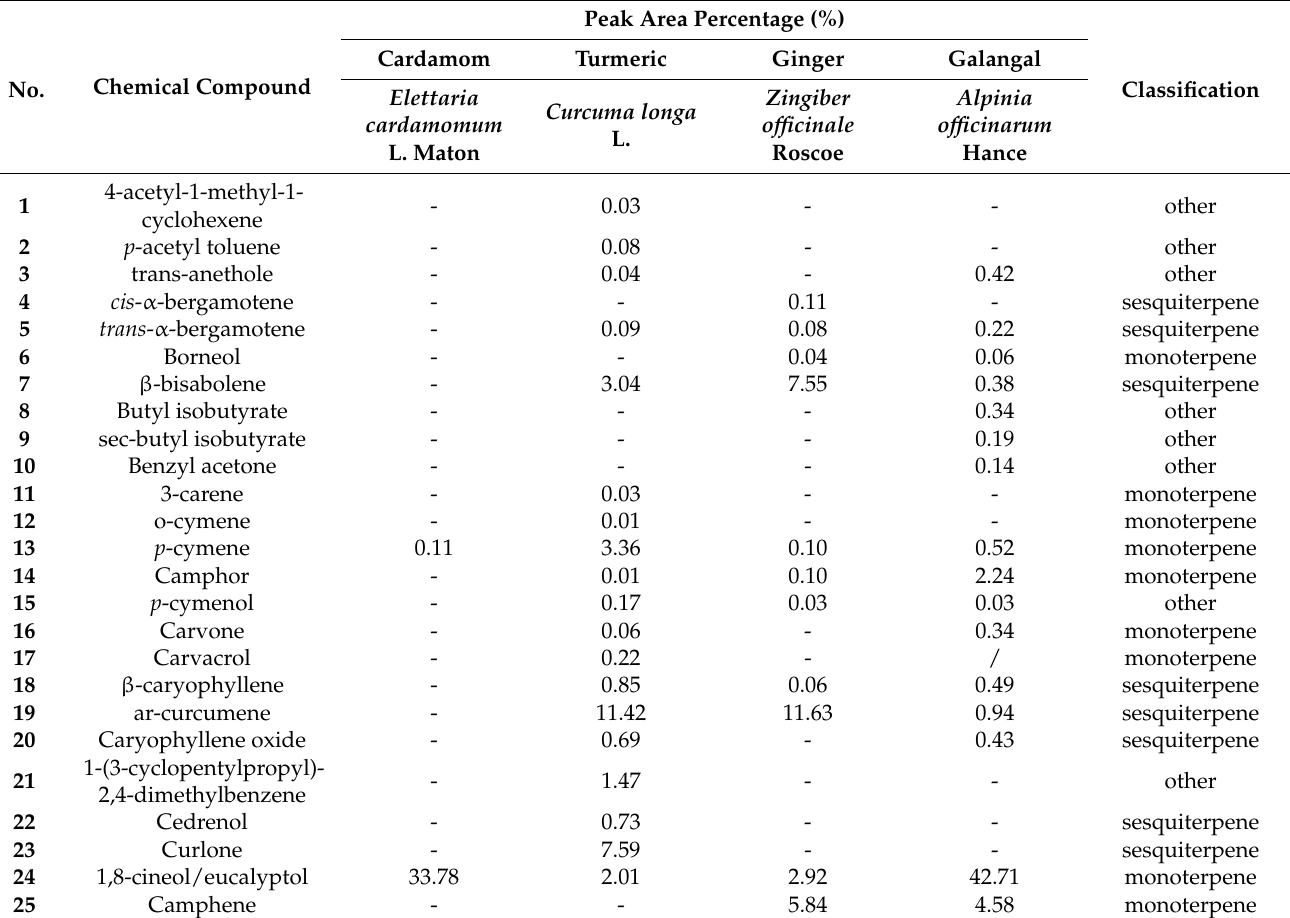
Table 1. Chemical composition of essential oils (EOs) of four Zingiberaceae plants identified by GC-MS/MS after 3 h of